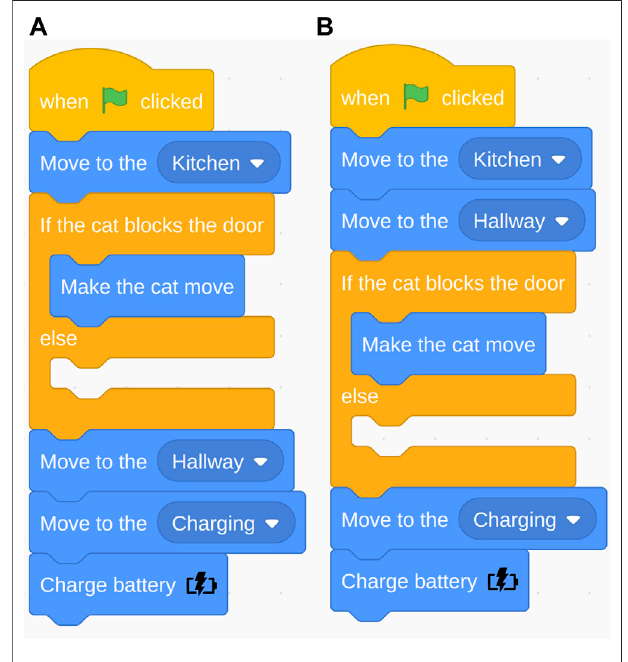
FIGURE 6 | Navigation task: Correct program (A) and improper order of robot action (move) and if-else conditional (B) .